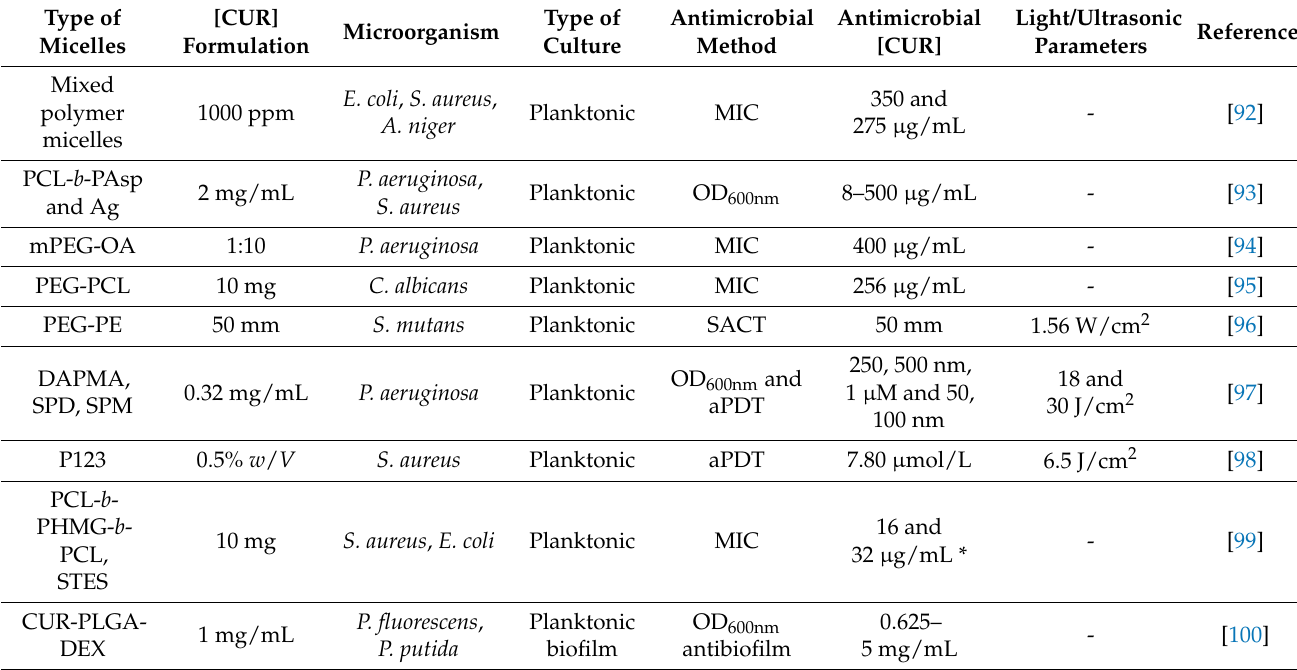
Table 2. Antimicrobial studies performed with CUR in